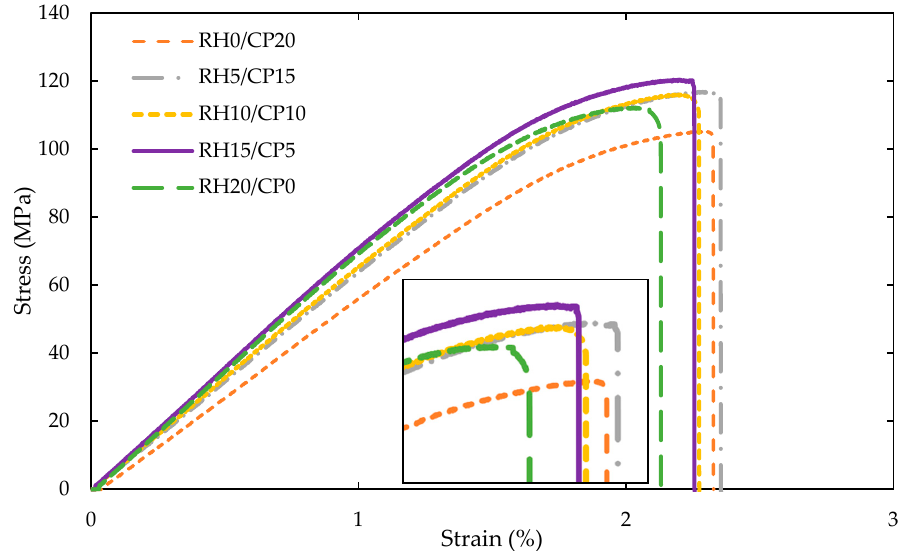
Figure 6. Typical flexural curves of RH/CP reinforced ABS blend composites.